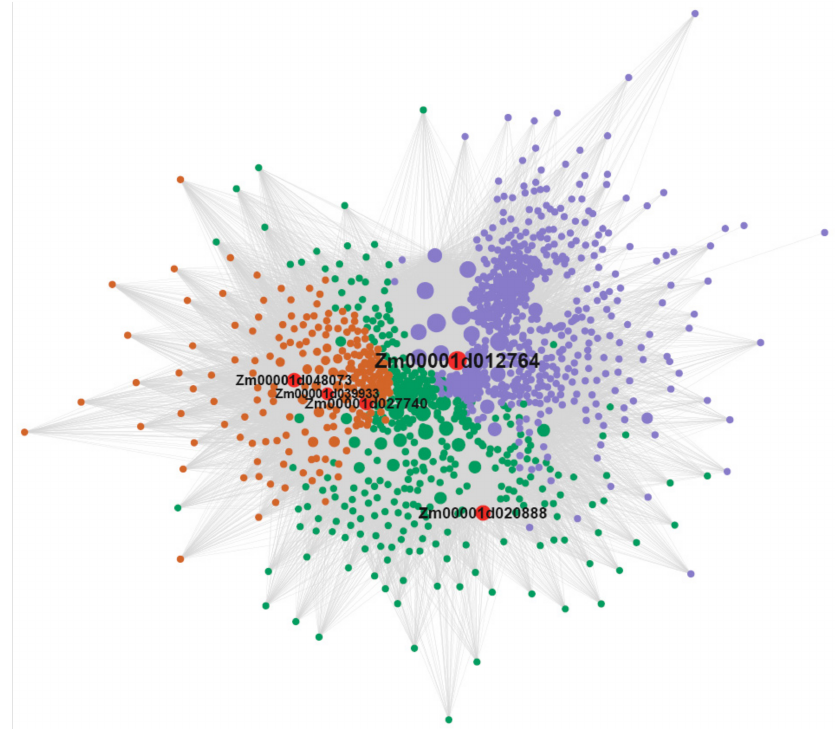
Figure 7. Analysis of candidate hub genes network interaction in greenyellow module.